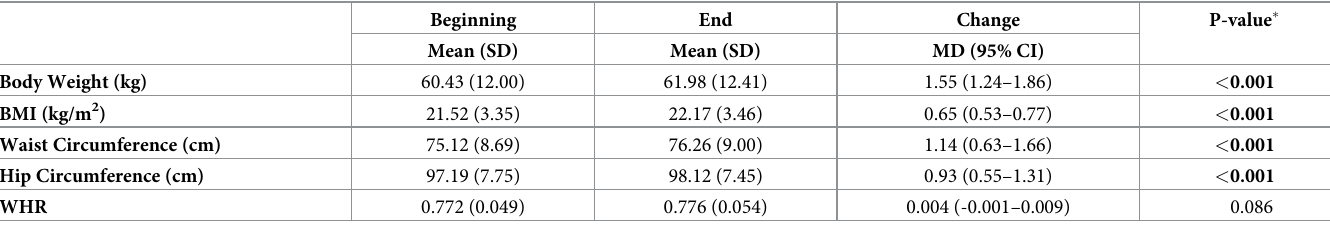
Table 1. Overall anthropometric trait trends in first year of